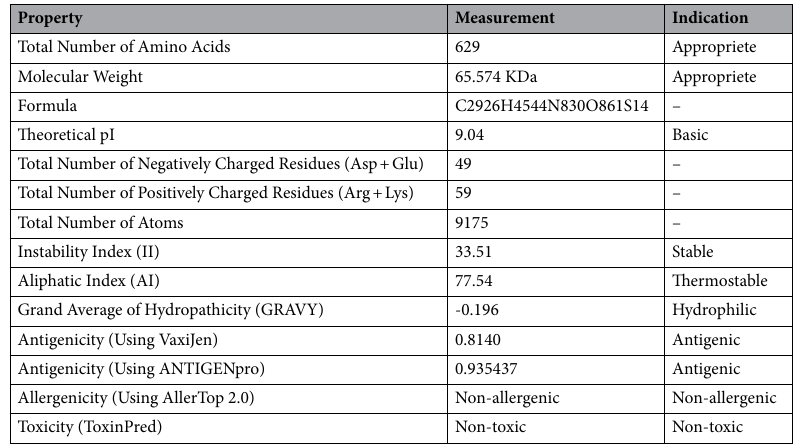
Table 6. The physicochemical properties of the translated form of the proposed mRNA vaccine.